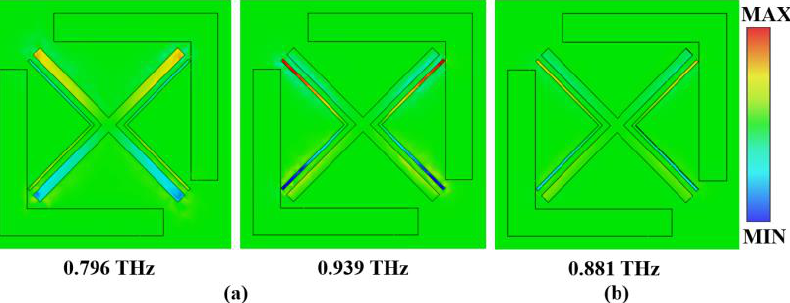
Figure 3. ( a ) Electric-field distribution of the trough frequencies; ( b ) electric-field distribution of the transmission-peak frequency.